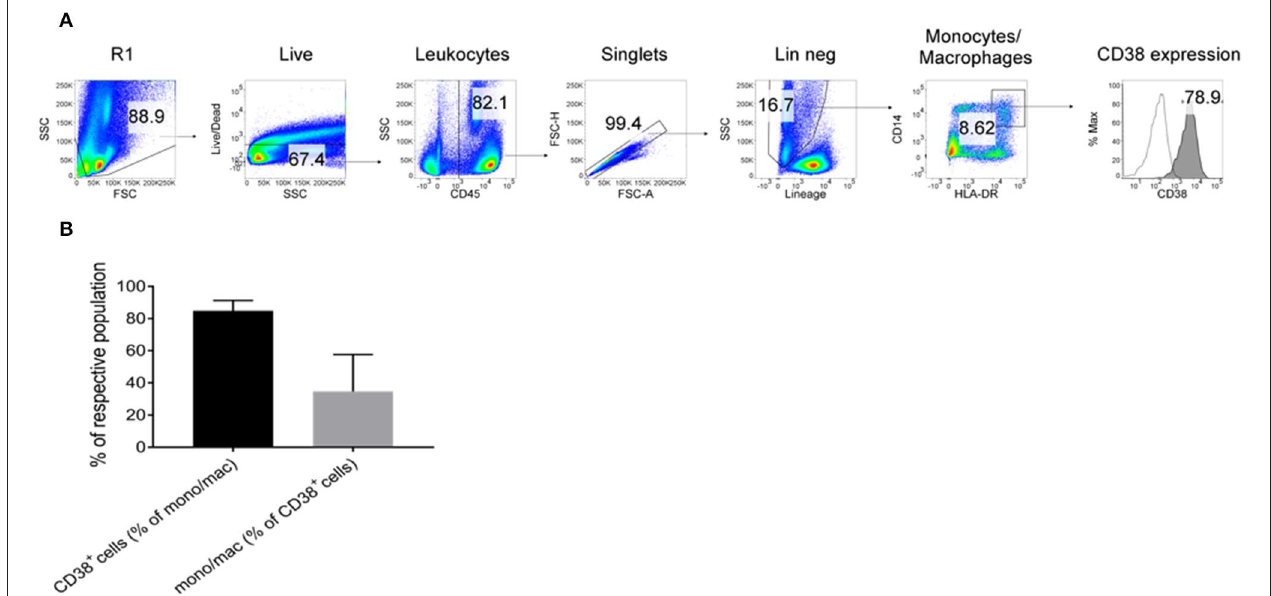
FIGURE 5 | Expression of CD38 + by tumor-infiltrating monocytes/macrophages further confirmed by flow cytometry. (A) Tumor-infiltrating leukocytes from four HCC patients were analyzed. Lineage + cells (CD3/CD7/CD19/CD20/CD56) were excluded in a dump channel. Monocytes/macrophages were identified by co-expression of CD14 and HLA-DR. Expression of CD38 (filled histogram) was determined with respect to the isotype control antibody (clear histogram). (B) % of monocytes/macrophages that expressed CD38 (black column) and % of CD38 + leukocytes that were monocytes/macrophages (gray column). The data represents the means ±